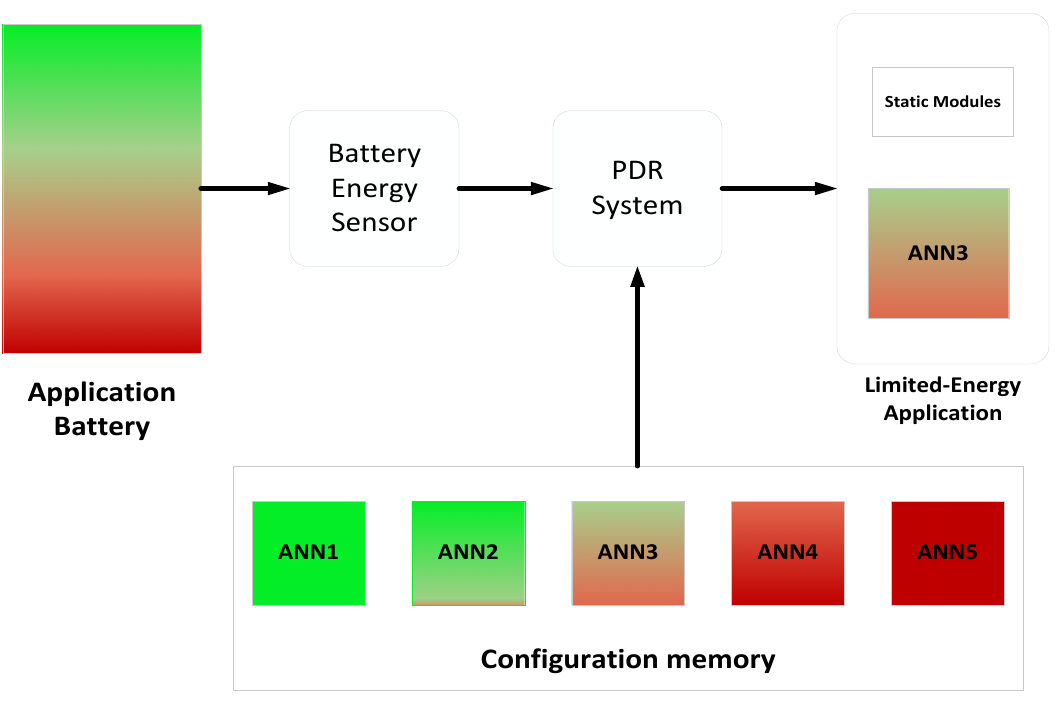
Figure 2. Limited-energy application block diagram for using energy adaptive neural